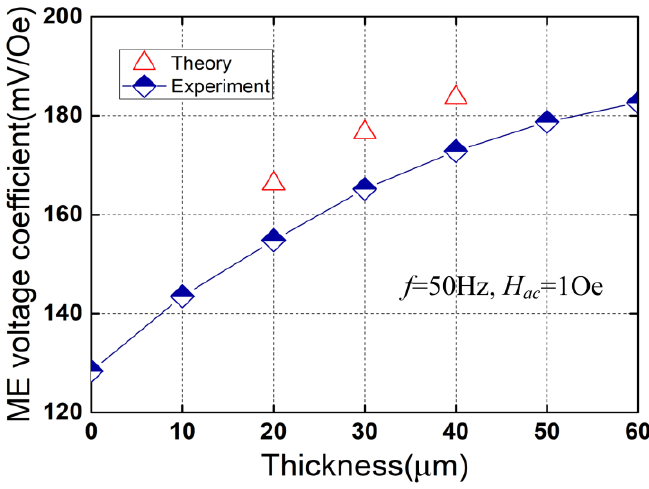
Figure 5. ME voltage coefficient versus the thickness of the high-permeability film.